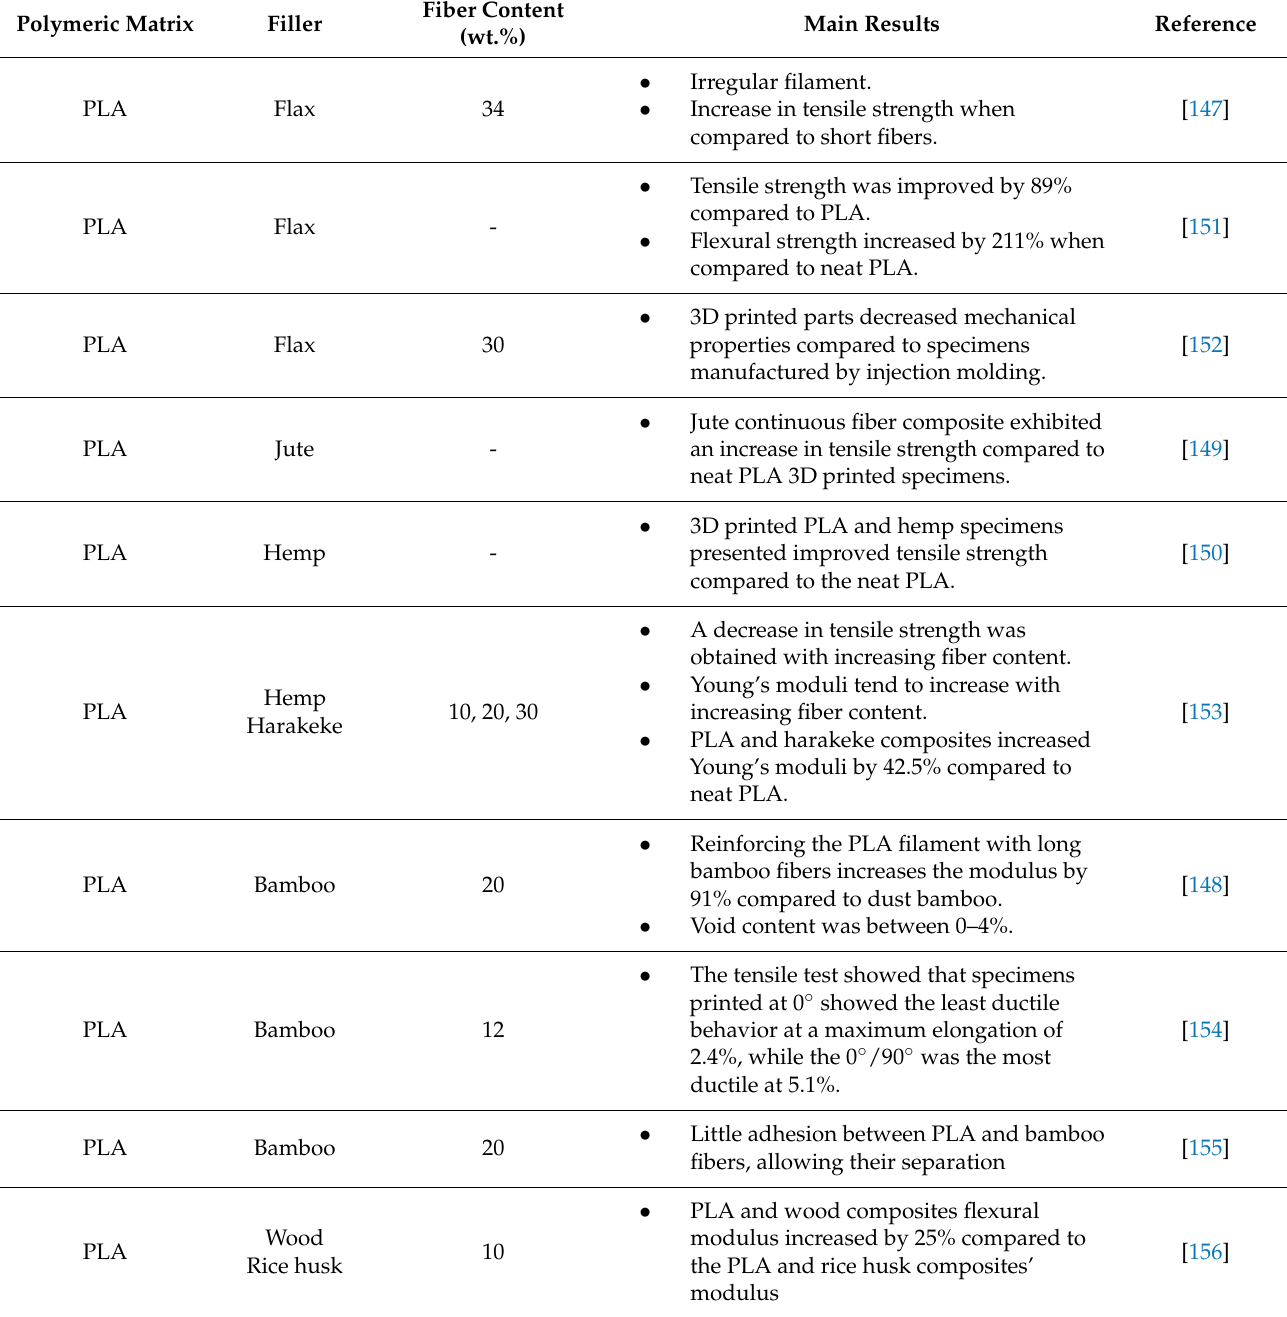
Table 3. Natural fiber biocomposites studied in FDM